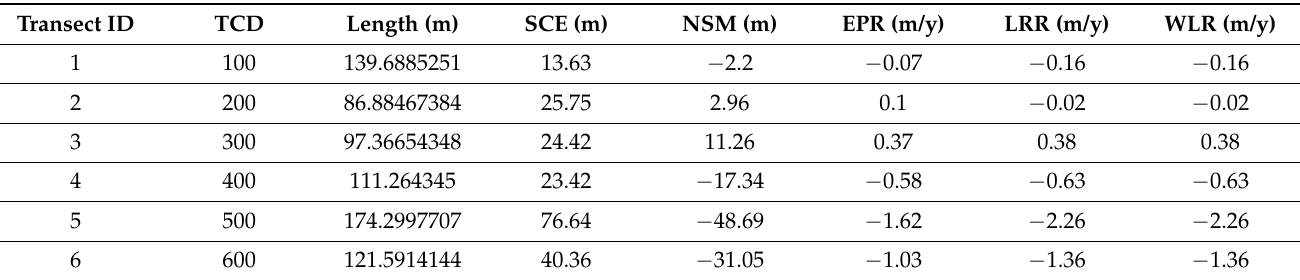
Table 5. Shoreline-change statistics for low-frequency sampling indicating accretion/erosion at each transect. Transect ID